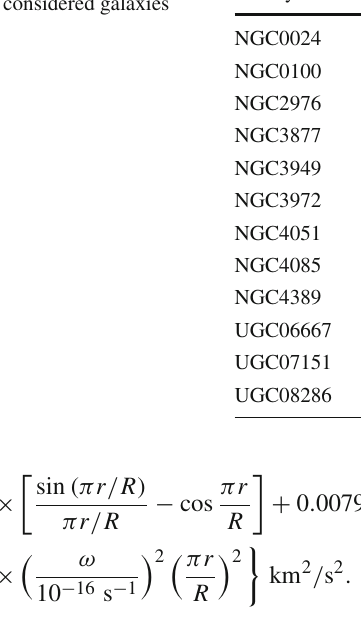
Table 1 The best-fit parameters for the 12 considered galaxies